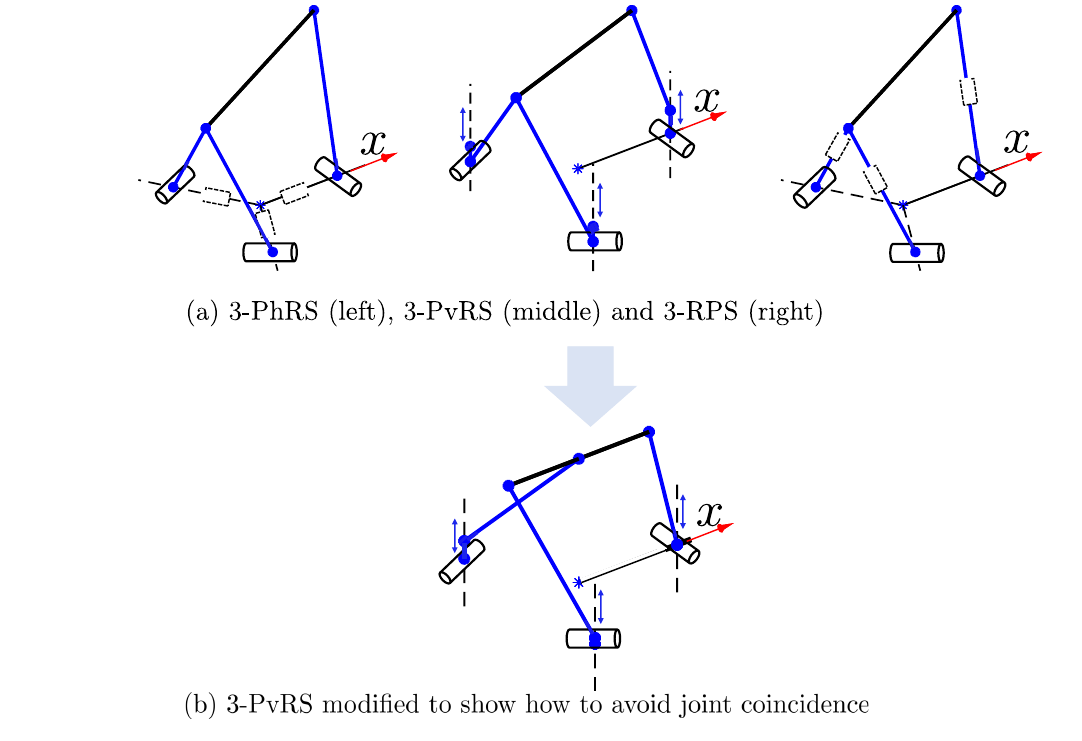
Figure 6. Optimal configuration for v x = v y =